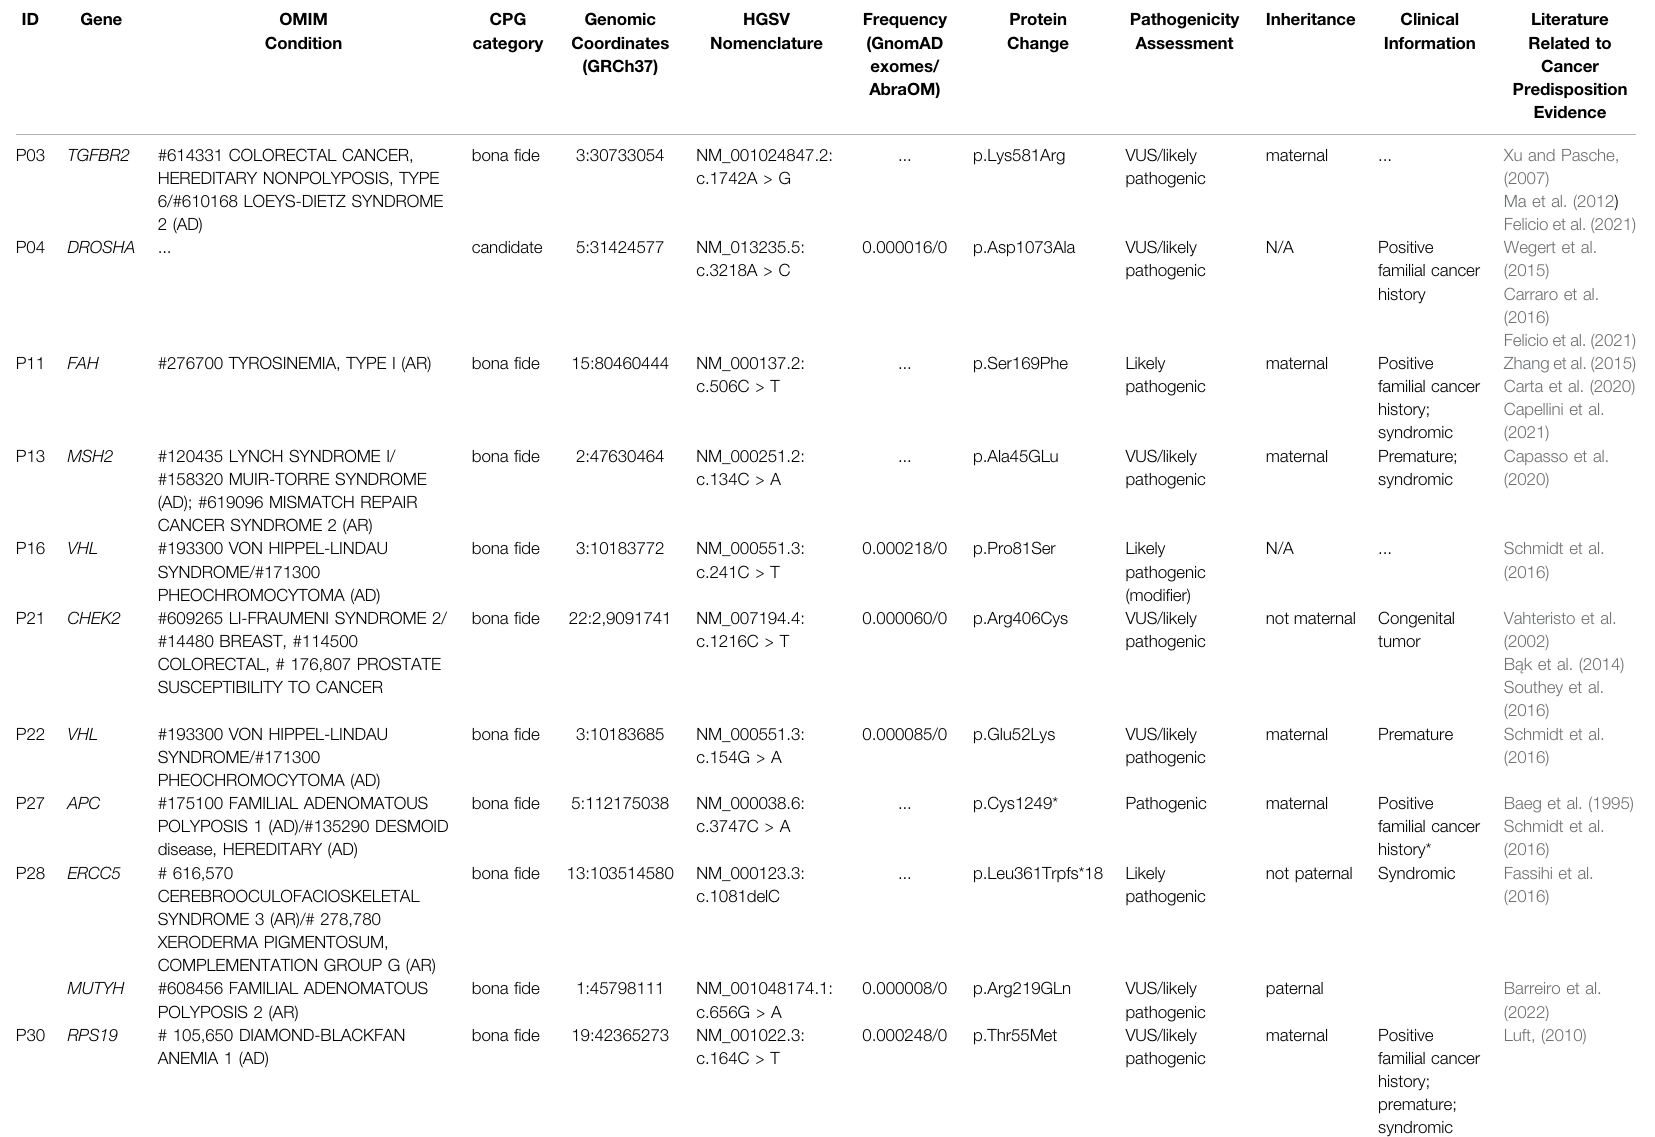
TABLE 2 | Description of 11 potentially pathogenic/likely pathogenic germline heterozygous variants mapped to 10 known/candidate cancer predisposition genes and detected in 10 hepatoblastoma